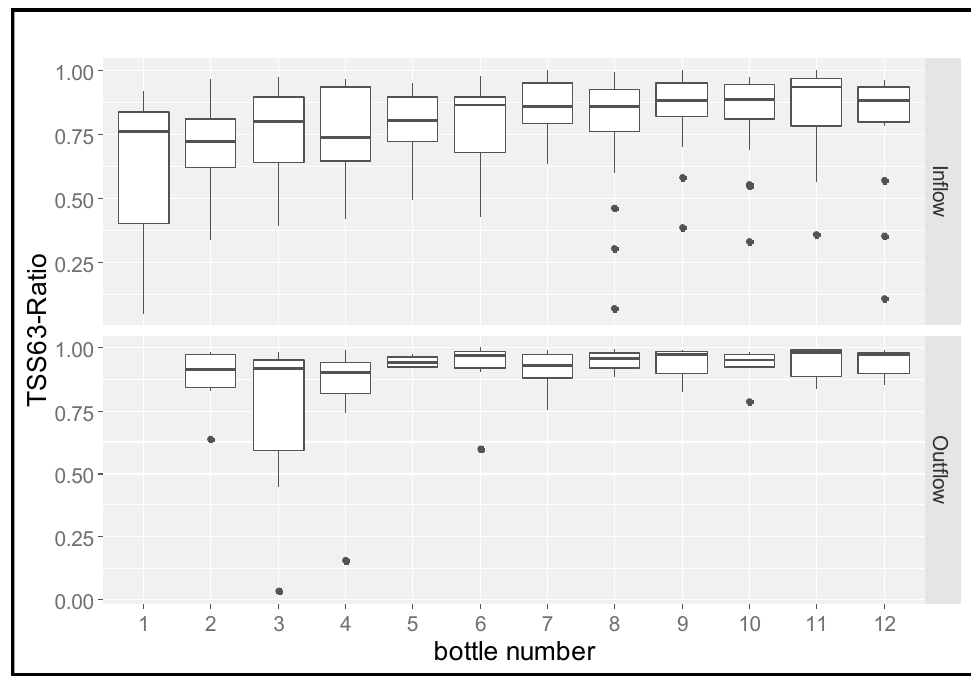
Figure 3. TSS63 ratio per composite sample bottle at SG during event sampling. Each bottle represents a 10 min time step. With numbers of samples per boxplot: for inflow min = 14, and max = 19 and for outflow min = 6, and max = 8. Boxplots with whiskers for inflow and outflow ratios summarize the statistical description of all bottle samples and show mean, median, 0.25 and 0.75 percentile, and 1.5 × inter-quartile range (IQR). Outliers are indicated as black dots.